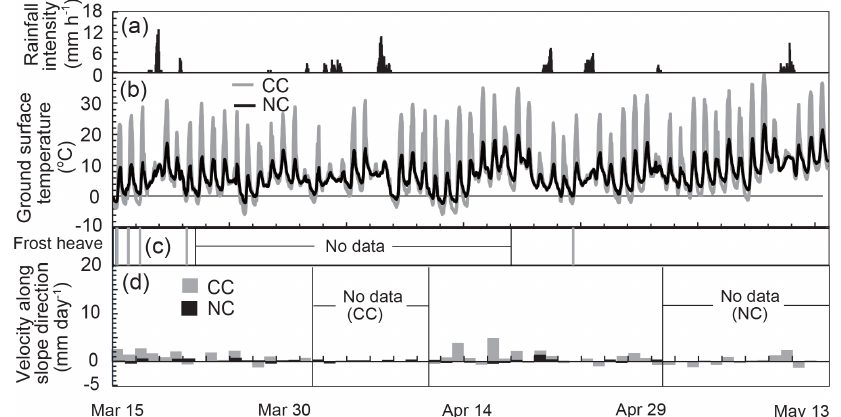
Figure 7. Comparison of microclimate conditions and sediment transport activities between sites CC and NC in spring (15 March to 15 May 2013). (a) Hourly rainfall intensity at site MU. (b) Ground surface temperature in sites CC (CCS) and NC (NCS). (c) Timing of frost heave in CCR monitored by TLC. Uplifting of the ground surface was not observed at NC in this period. (d) Velocity of ground surface sediment by soil creep in CC (plot CCR) and NC (plot NCR) obtained from TLC images.